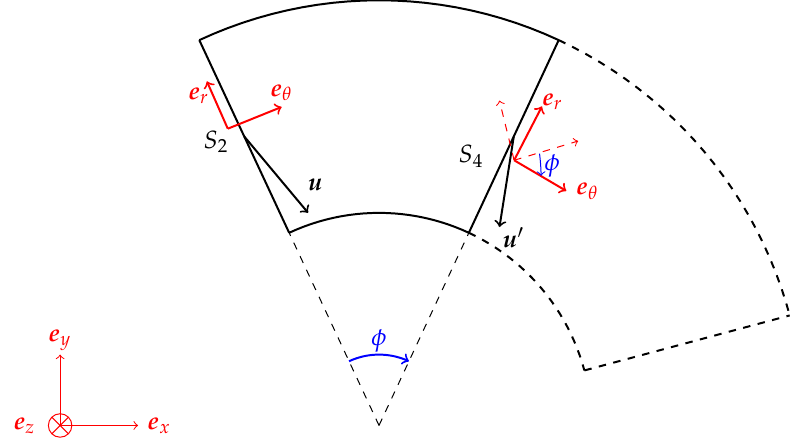
Figure A1. Schematic overview of a 2D curve with periodic boundary